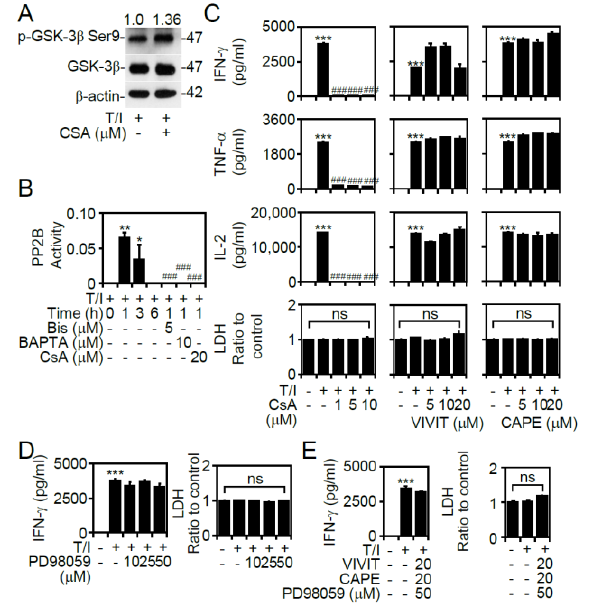
Figure 4. Treatment with T/I induces GSK-3β activation and cytokine production through calcineurin (PP2B) signaling. ( A ) Western blotting detected the phosphorylation of GSK-3β (47 kDa) in CD4 + lymphocytes treated with the T/I combination in the presence of cyclosporine A (CsA, 10 μM). CD4 + lymphocytes were pretreated with Bis, BAPTA, CsA, VIVIT, CAPE, PD98059, or a combination of VIVIT, CAPE, and PD98059 for 0.5 h and then stimulated with T/I for 6 h. ( B ) The PP2B activity